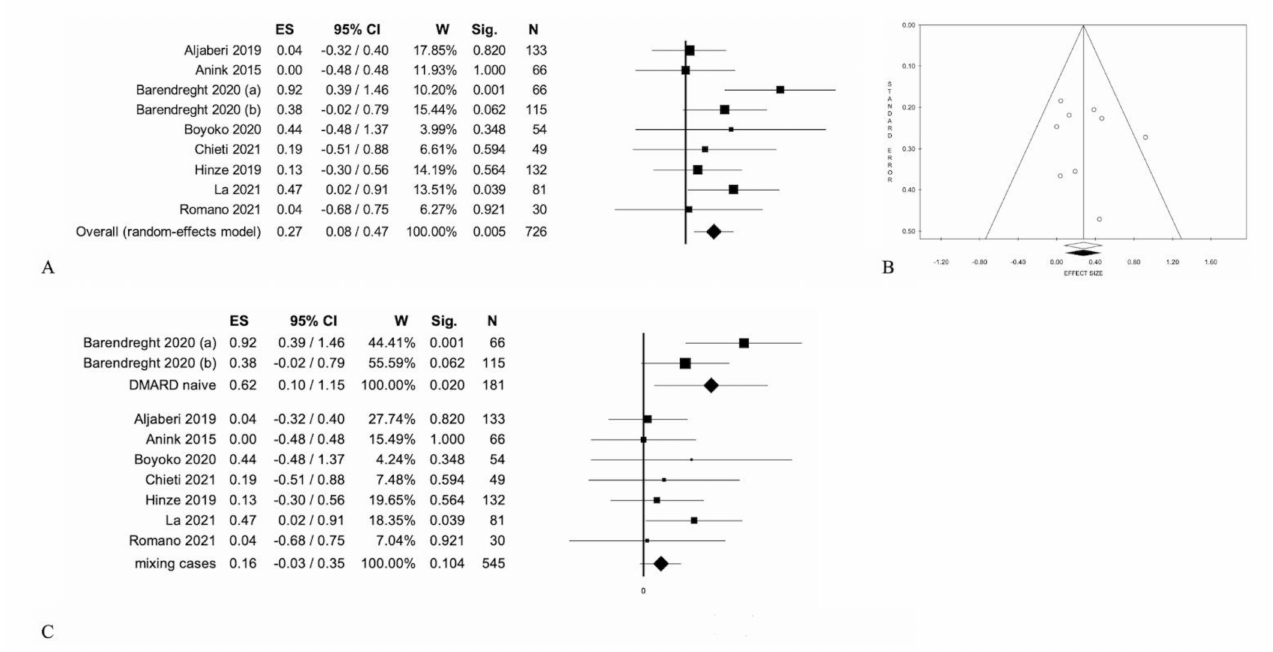
Figure 2. Active disease (pauci and polyarticular forms) vs. inactive disease: ( A ) Forest Plot of overall cases; ( B ) Funnel Plot; ( C )forest plot according baseline therapy.